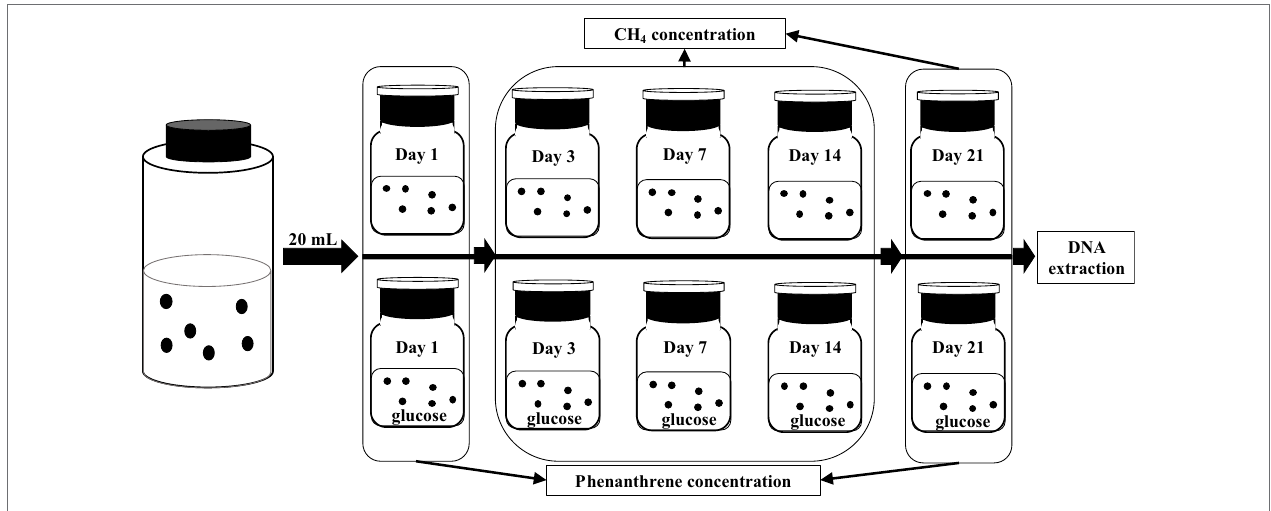
FIGURE 2 | The diagram showing the experiment design to investigate the cometabolic effect of glucoe on the MPR and PDR of the enriched